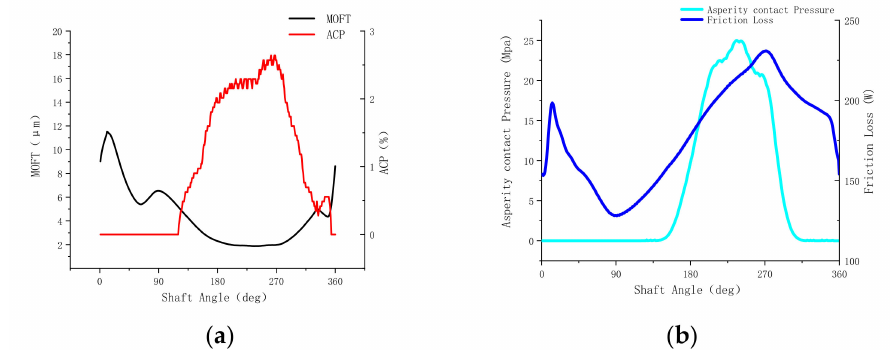
Figure 6. Calculation results at 3000 r / min with 60 MPa (peak load): ( a ) Minimum oil film thickness and asperity contact percentage; ( b ) Friction power consumption and asperity contact pressure.